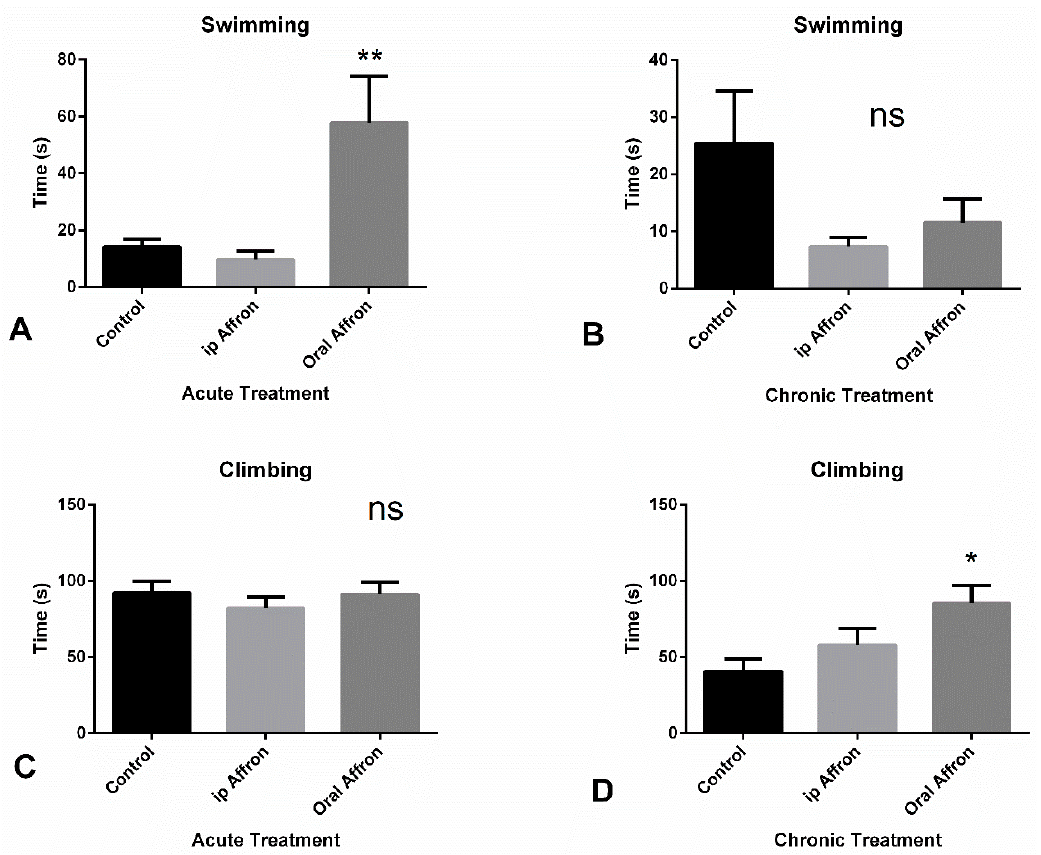
Figure 2. (A ) and ( B ): Average time spent in immobility or swimming in the Porsolt test in animals receiving either an acute or a chronic treatment with affron through the intraperitoneal (gray column) or the oral (black column) route, respectively (** p < 0.01). ( C ) and ( D ): Average time climbing in the acute and chronic treatments, respectively (* p < 0.05; ns = Non Significant). The tests